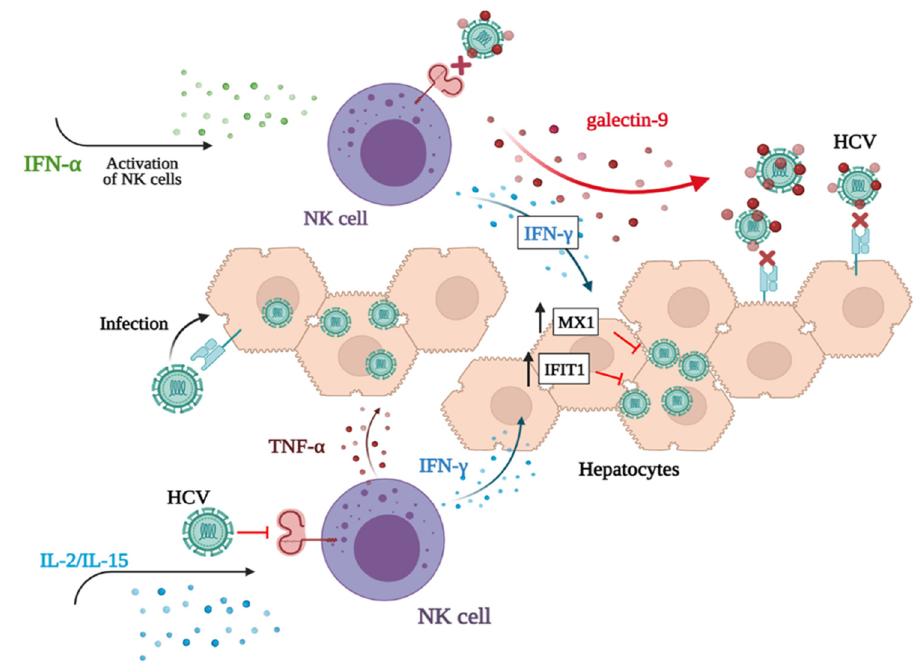
Figure 8. Cartoon depicting the response of NK cells to HCV infection following IL-2/IL-15 or IFN- α activation. The activation of NK cells with IFN- α induces the secretion of IFN- γ and galectin-9. IFN- γ drives the up-regulation of MX1 and IFIT1 by target hepatocytes, which contain/inhibit HCV replication. Extracellularly, Galectin-9 reduces HCV infectivity, putatively through its binding to viral-surface glycoprotein. This binding not only likely prevents the re-infection of target cells but also inhibits HCV ligation to receptors on NK-cell surface, thus interfering with the impairment of effector cells by the virus. The activation of NK cells with IL-2/IL-15 primarily induces the release of antiviral cytokines TNF- α and IFN- γ and only partially contains HCV infection. Galectin-9 is